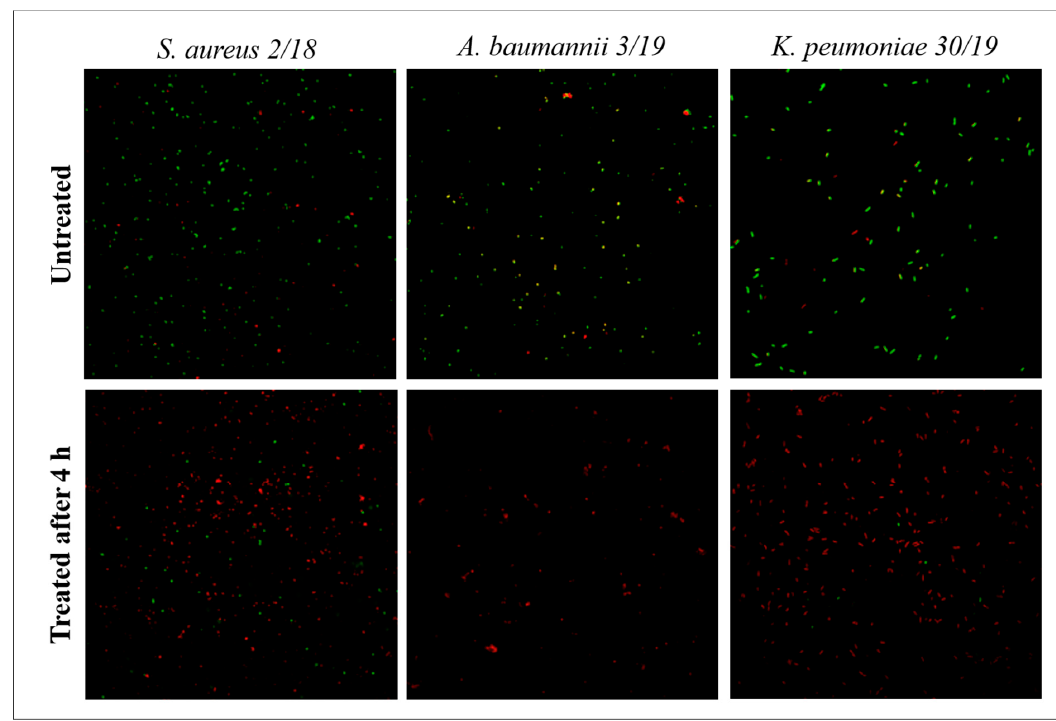
Figure 3. Representative images of confocal laser scanning microscopy of MDR bacteria treated with the distilled extract of bergamot and stained with acridine orange. “Untreated”: control of bacterial growth; “treated”: strains treated with the distilled extract of bergamot (MBC). Green fluorescence shows the presence of living cells; red fluorescence shows the presence of dead cells.